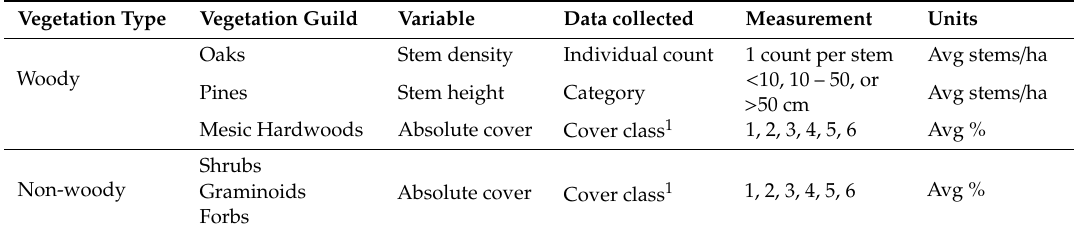
Table 2. Data collected and used in the analyses for all recorded understory vegetation-stem density and absolute cover were used for woody species, and absolute cover was used for non-woody species. Woody stem counts were recorded into three height classes, < 10 cm, 10–50 cm, and > 50 cm, to quantify recruitment potential; and cover classes were recorded as follows according to the Fire and Fire Surrogate Study (FFSS) sampling protocol: 1 ( < 1%), 2 (1%–10%), 3 ( > 10%–25%), 4 ( > 25%–50%), 5 ( > 50%–75%), and 6 ( > 75%)